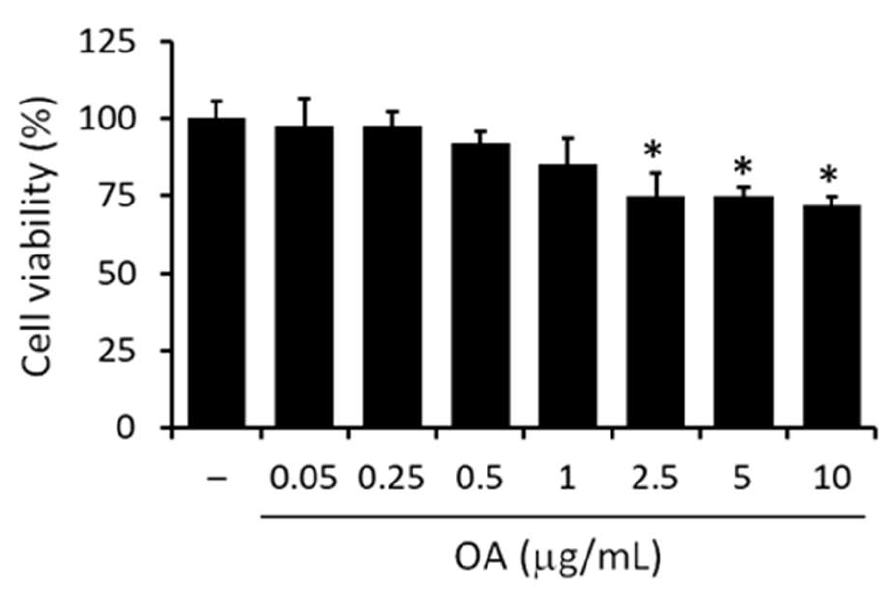
Figure 6. Effect of OA on RAW 264.7 cell viability. Cells were starved for 6 h and then treated for a further 18 h with doses of OA between 0.05–10 µ g/mL. Values are expressed as percentages